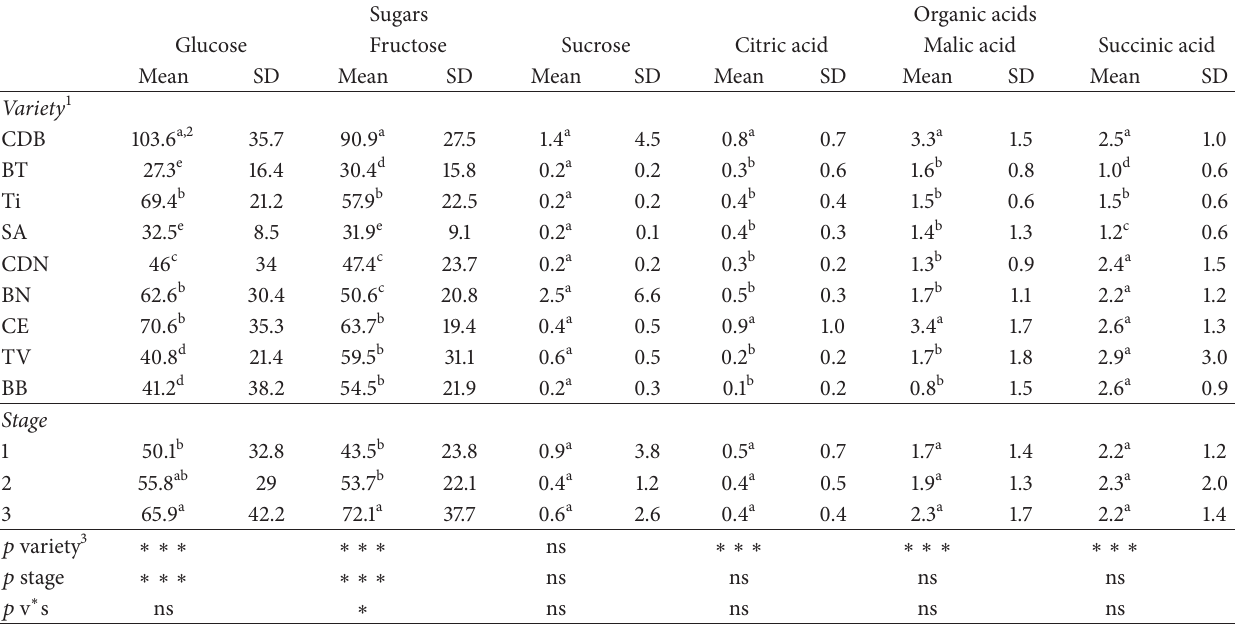
Table 2: Sugars and organic acids in skin of the brebas according to fig tree varieties and commercial ripening stage (gkg −1 FW). Sugars Organic acids Glucose Fructose Sucrose Citric acid Malic acid Succinic acid Mean Variety 1